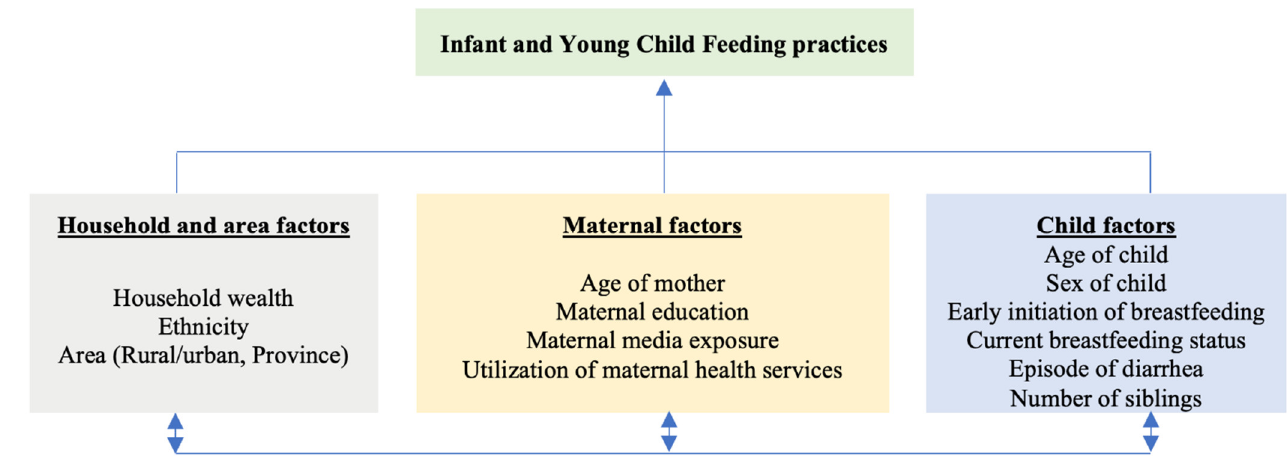
Figure 2. Conceptual framework of the study. Table 1. Description of explanatory